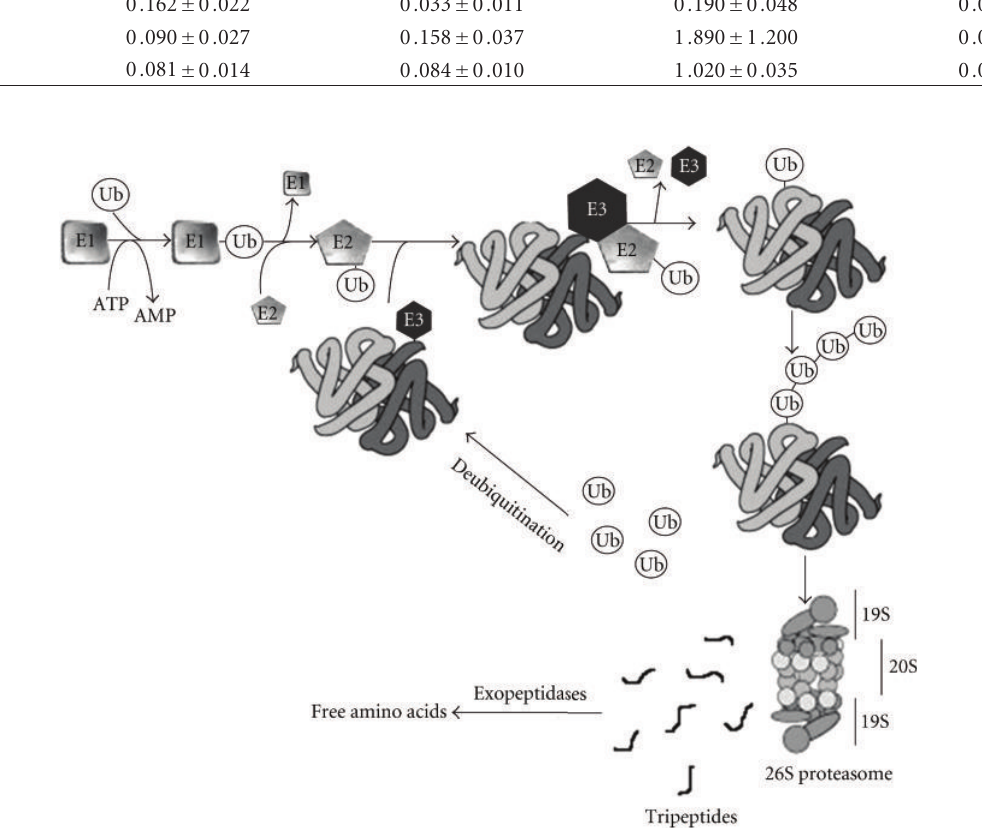
Figure 2: Scheme of UPS